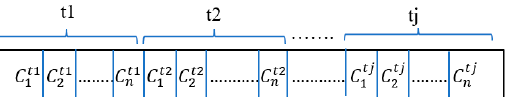
Figure 7. Capacitor problem coding method with fixed and switching capacitors.